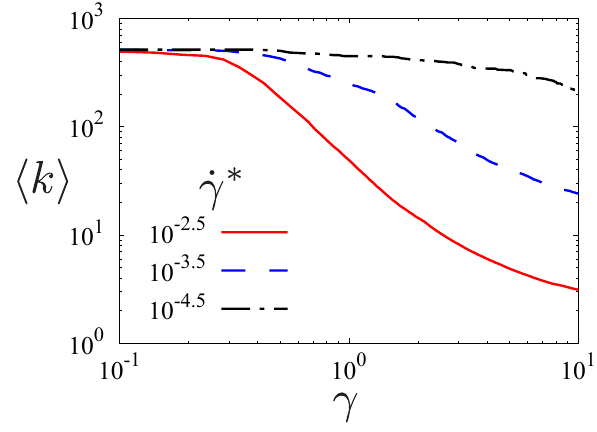
Figure 5. Shear stress ( P x y ) field for ˙ γ ∗ = 10 − 3 and γ = 1 . 0, where P x y is evaluated from Eq. (4) and we have introduced ≡ P P ∗ x y / k n . The color indicates the magnitude of the shear x y